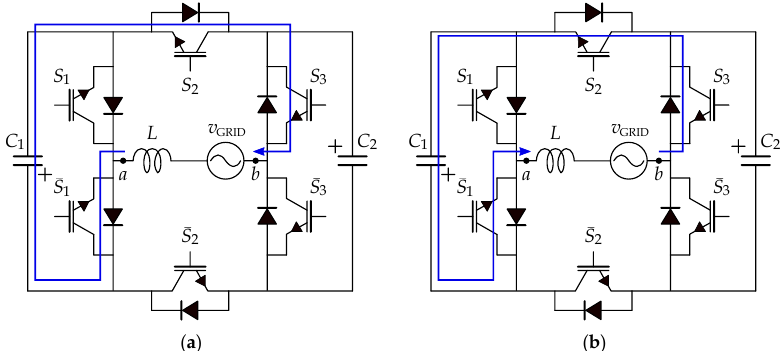
Figure 3. Conduction path of devices in mode 3 of CCHB - MLI : ( a ) Current direction from a to b . ( b ) Current direction from b to a .